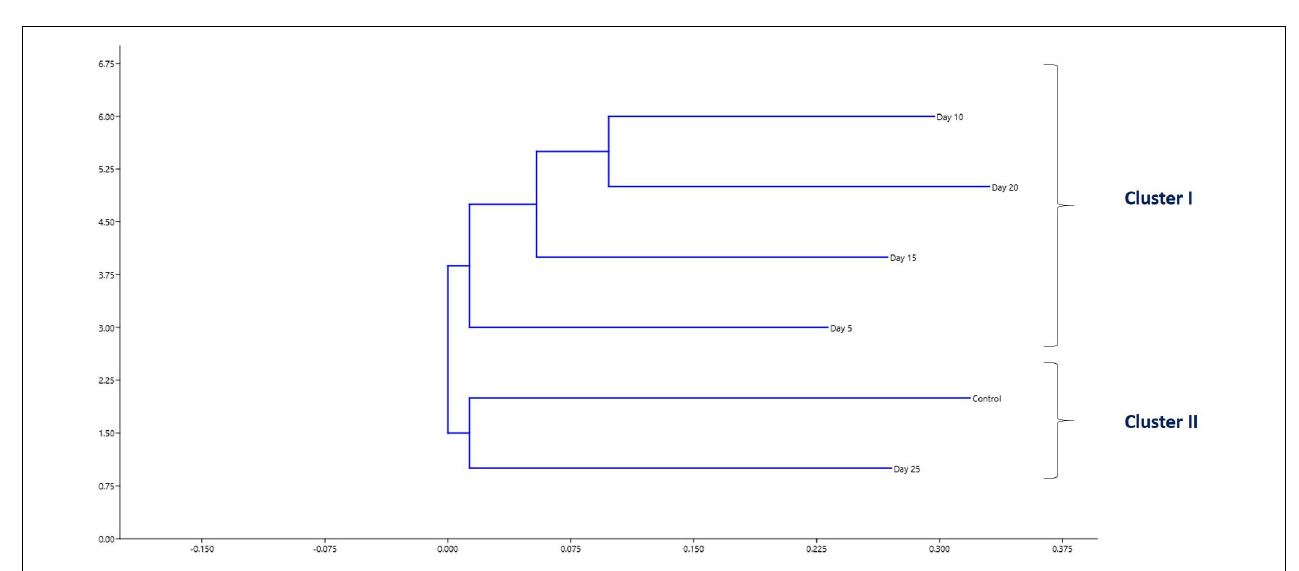
FIGURE 5 | Hierarchical clustering based on the average Bray-Curtis similarity